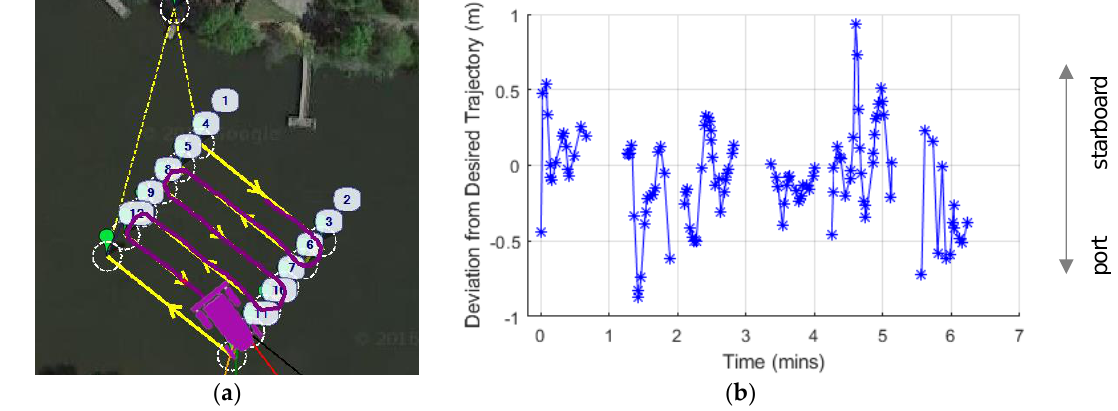
Figure 16. Tracking performance of a prototype at Lake Raleigh: ( a ) desired and actual trajectories as displayed from Mission Planner software and ( b ) corresponding boat deviations from intended trajectories (180° turns excluded).